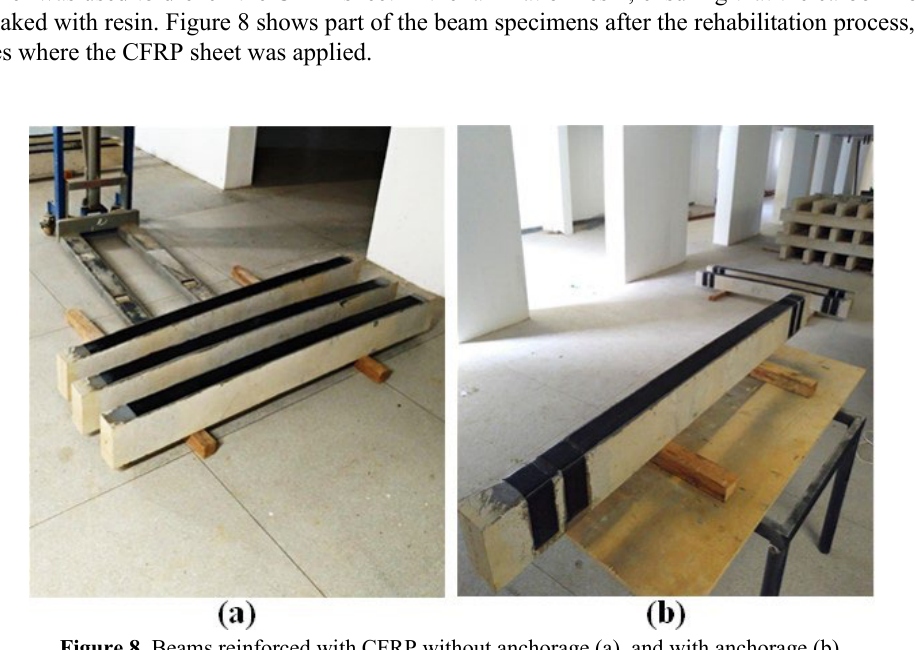
Figure 8. Beams reinforced with CFRP without anchorage (a), and with anchorage (b).